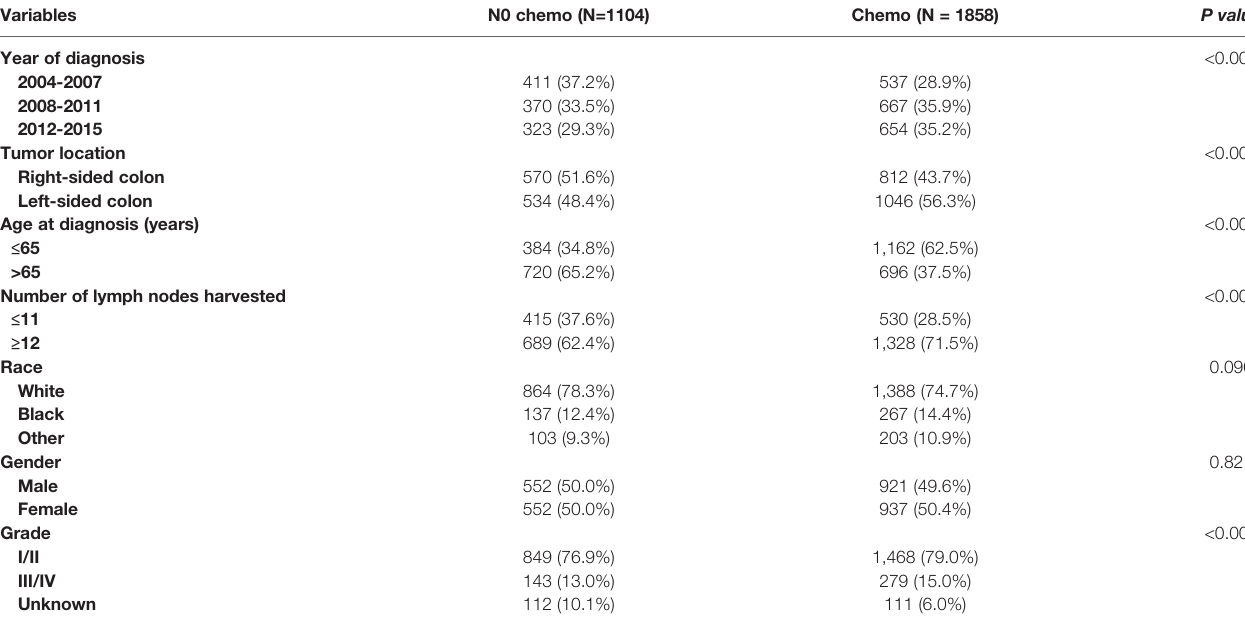
TABLE 3 | Clinicopathologic characteristics of T1N+ colon cancer patients according to the receipt of chemotherapy before propensity score matching. Variables N0 chemo (N=1104) Chemo (N =